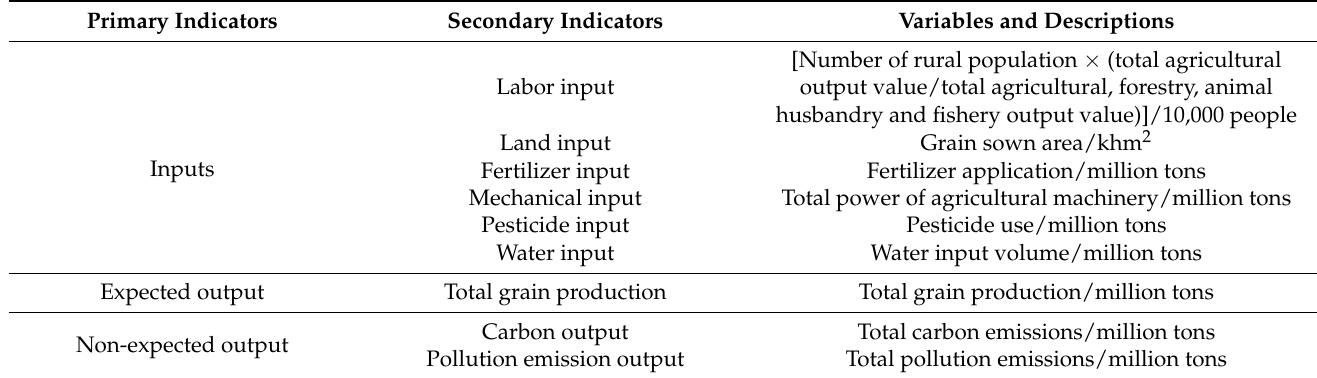
Table 1. Green grain production efficiency evaluation index